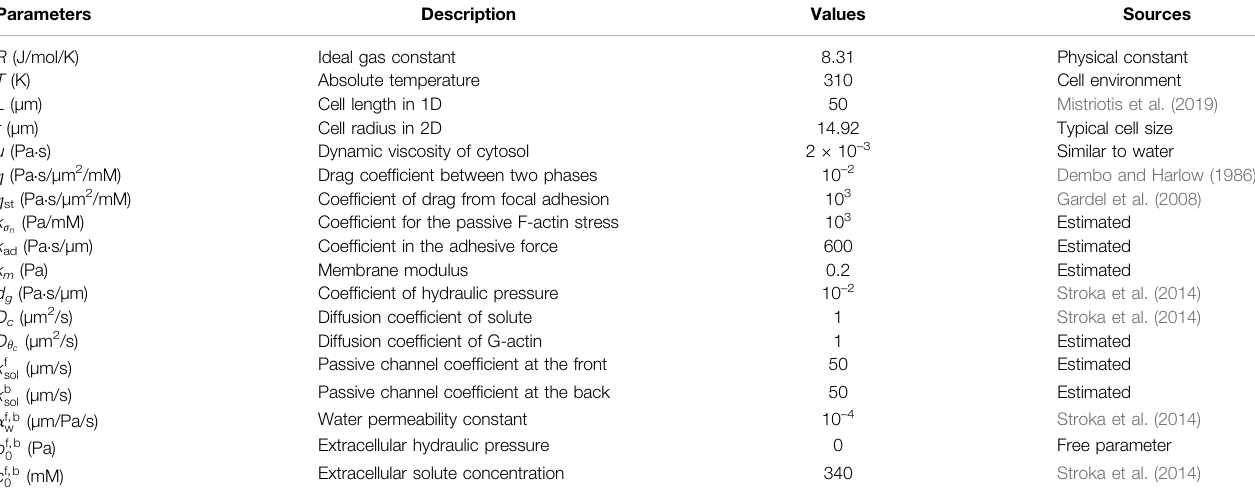
Table 1 | Parameters used in the one-dimensional model. These are the default parameters unless otherwise speci fi ed.